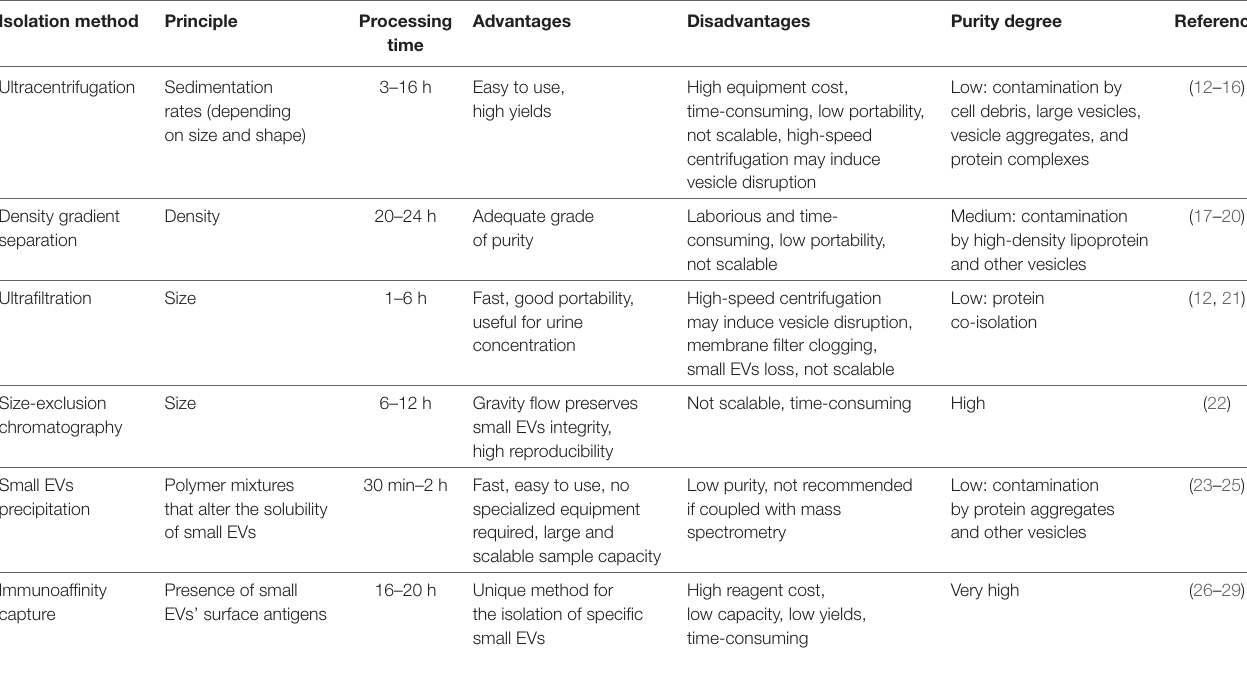
Table 1 | Overview of various small extracellular vesicles (EVs) isolation